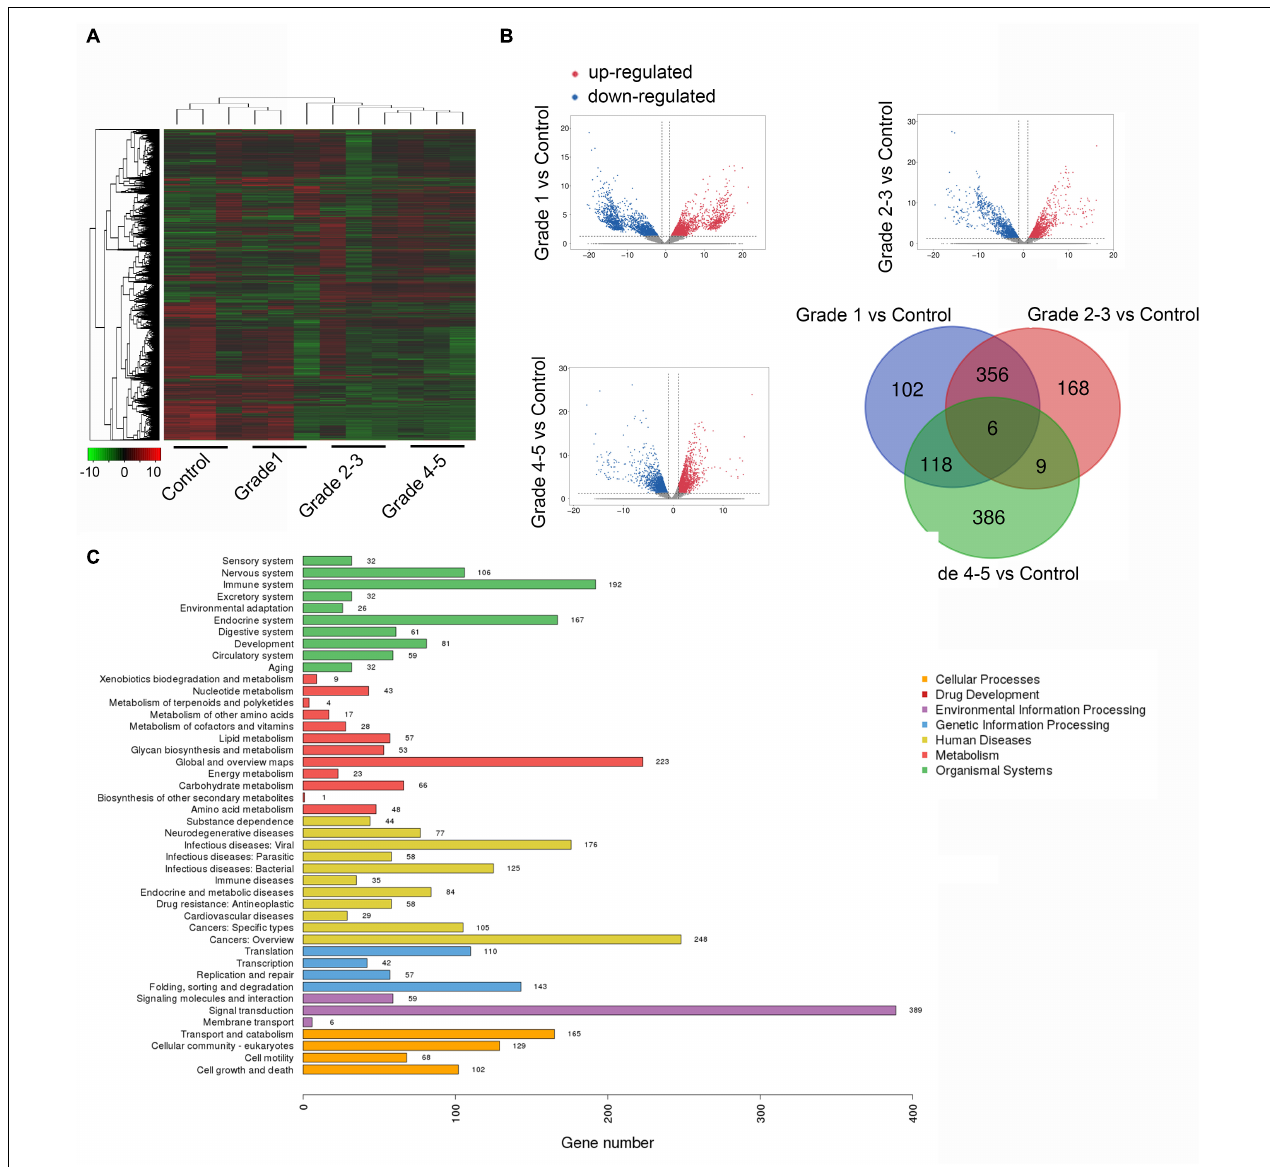
FIGURE 1 | The landscape of circRNA expression in plasma sample of PD and healthy controls. (A) Cluster analysis of differently expressed circRNAs (three plasma samples from patients diagnosed with PD and three healthy controls). (B) The scatter plots of dysregulated circRNAs in different stage of PD comparing with healthy control. (C) Candidate gene pathway